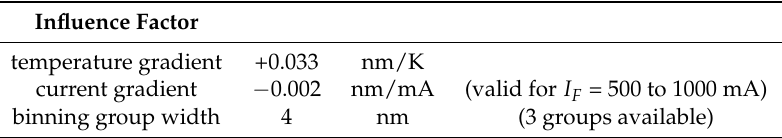
Table 1. Peak wavelength influence factors for a deep blue high-power LED OSRAM LD W5SM. Values calculated based on datasheet